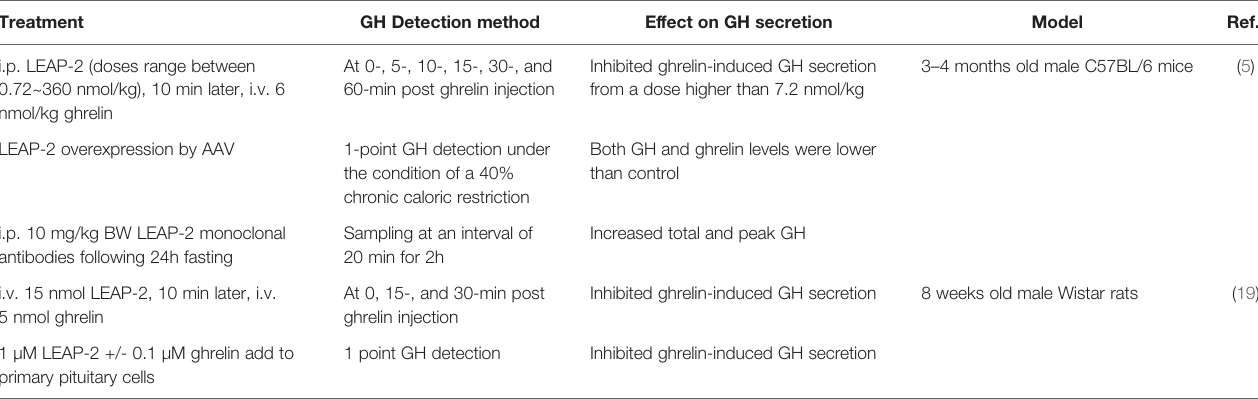
TABLE 2 | The effect of LEAP-2 on GH release based on